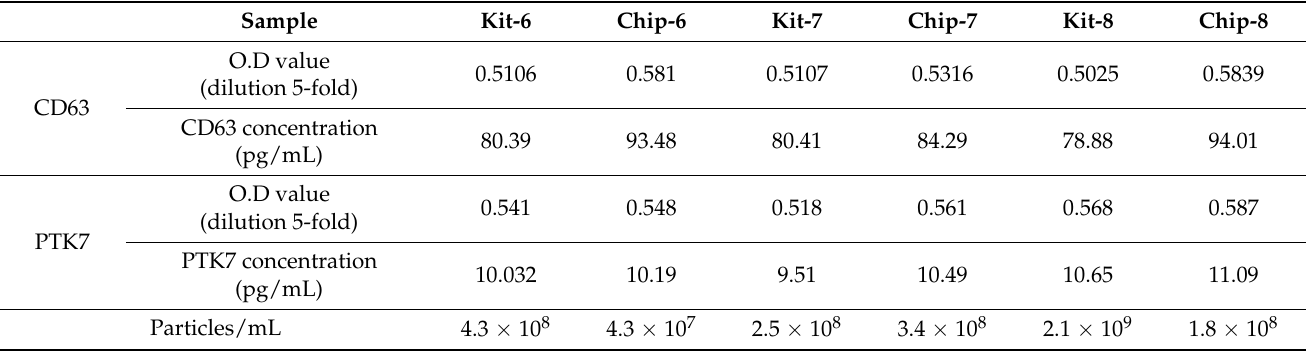
Table 1. Protein concentration of EVs